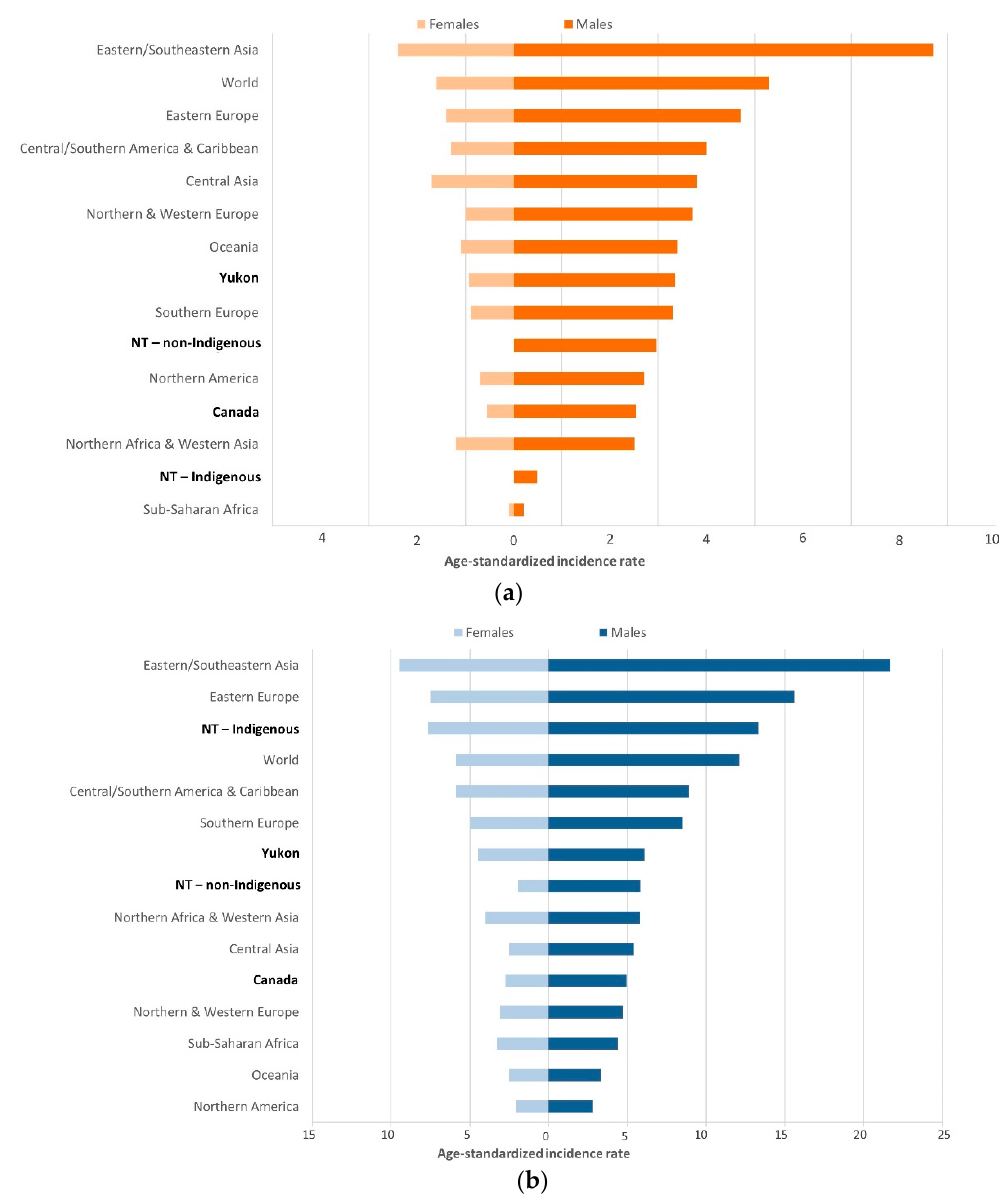
Figure 3. ( a ) Estimated cardia gastric cancer age-standardized incidence rates (ASRs per 100,000) by population and sex; ( b ) Estimated non-cardia gastric cancer ASRs (per 100,000) by population and sex; northern territories, Canada, and world regions, various years. Age-standardized incidence rates (ASRs) standardized to the World Population. Canada and Yukon include cases diagnosed during 2003–2007; Northwest Territories (NT) includes cases diagnosed during 1997–2015. World and regional cardia and non-cardia gastric cancer ASR estimates from Colquhoun, et al. (2014) [2].